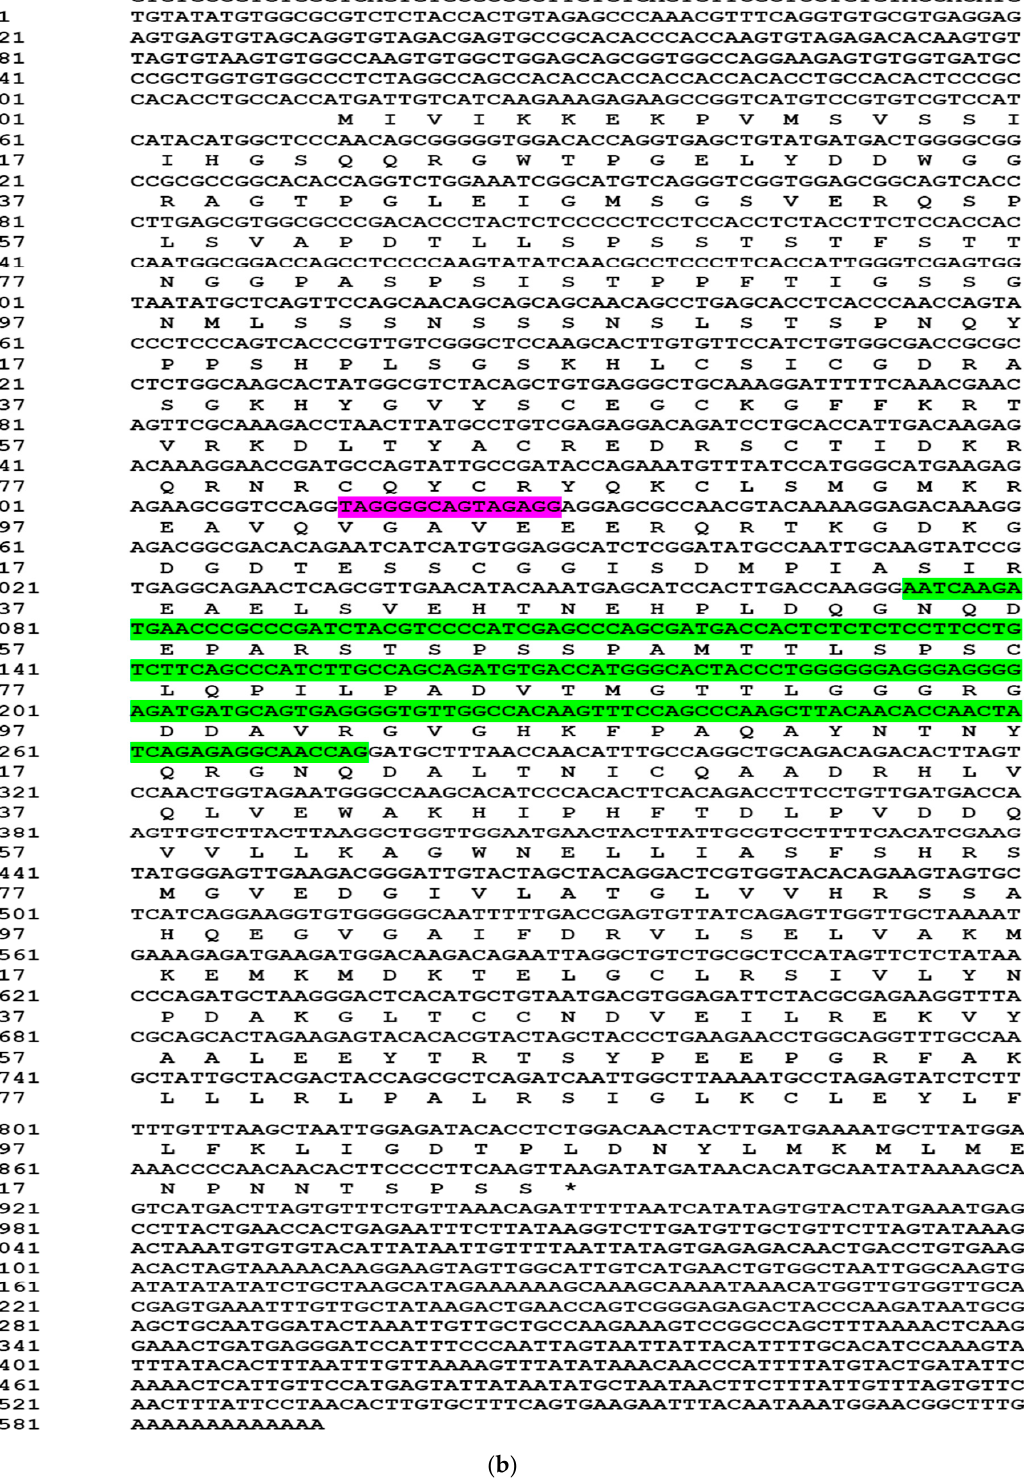
Figure 1. ( a ) Full-length cDNA of PcEcR and its encoded amino acid sequence; ( b ) Full-length cDNA of PcRXR and its encoded amino acid sequence. The two splice variant sequences: one with the red background is a 15 bp insertion/deletion alternatively spliced intron that only exists in PcRXR1 and PcRXR3 ; the second with green background is a 204 bp insertion/deletion alternatively spliced intron that only exists in PcRXR1 and PcRXR2 .